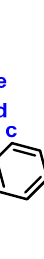
Figure 1. Structure and codes of hydrogen atoms of 4-trylaniline.